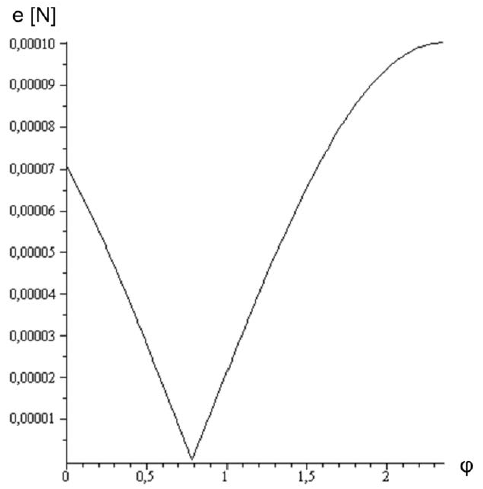
Figure 12: The graph of error indicator e = e ( φ ) for Example